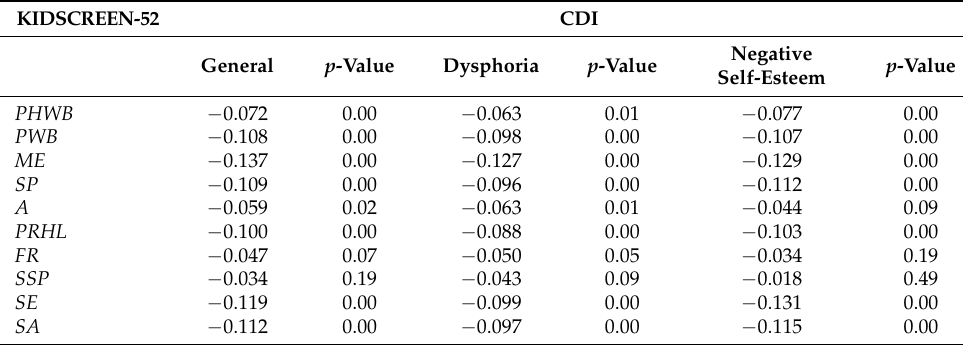
Table 3. Pearson’s correlation coefficients between the HRQoL and CDI.